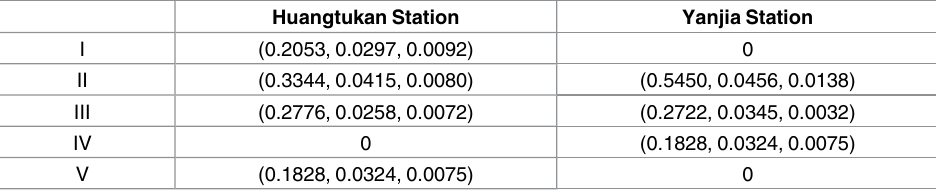
Table 8. Calculation results of CCD.